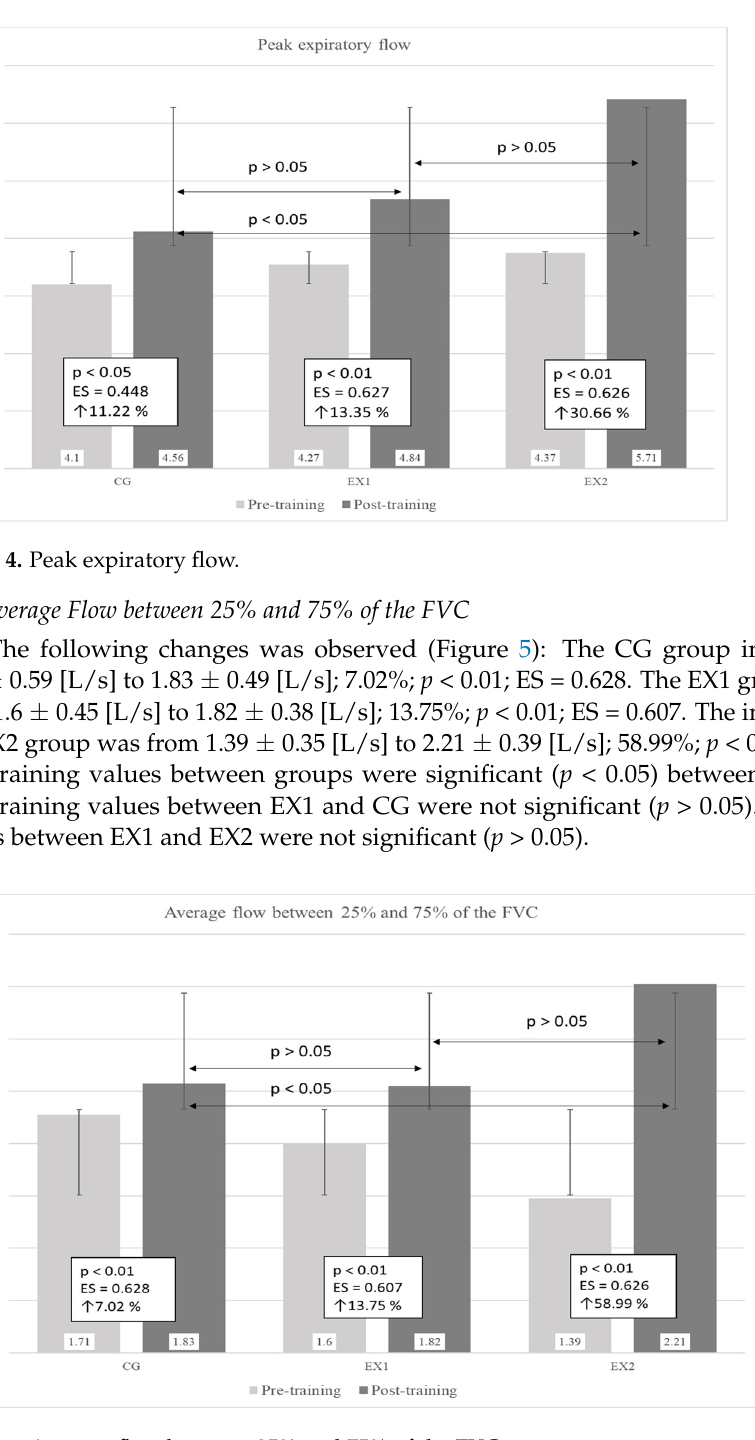
Figure 5 . Average flow between 25% and 75% of the FVC.